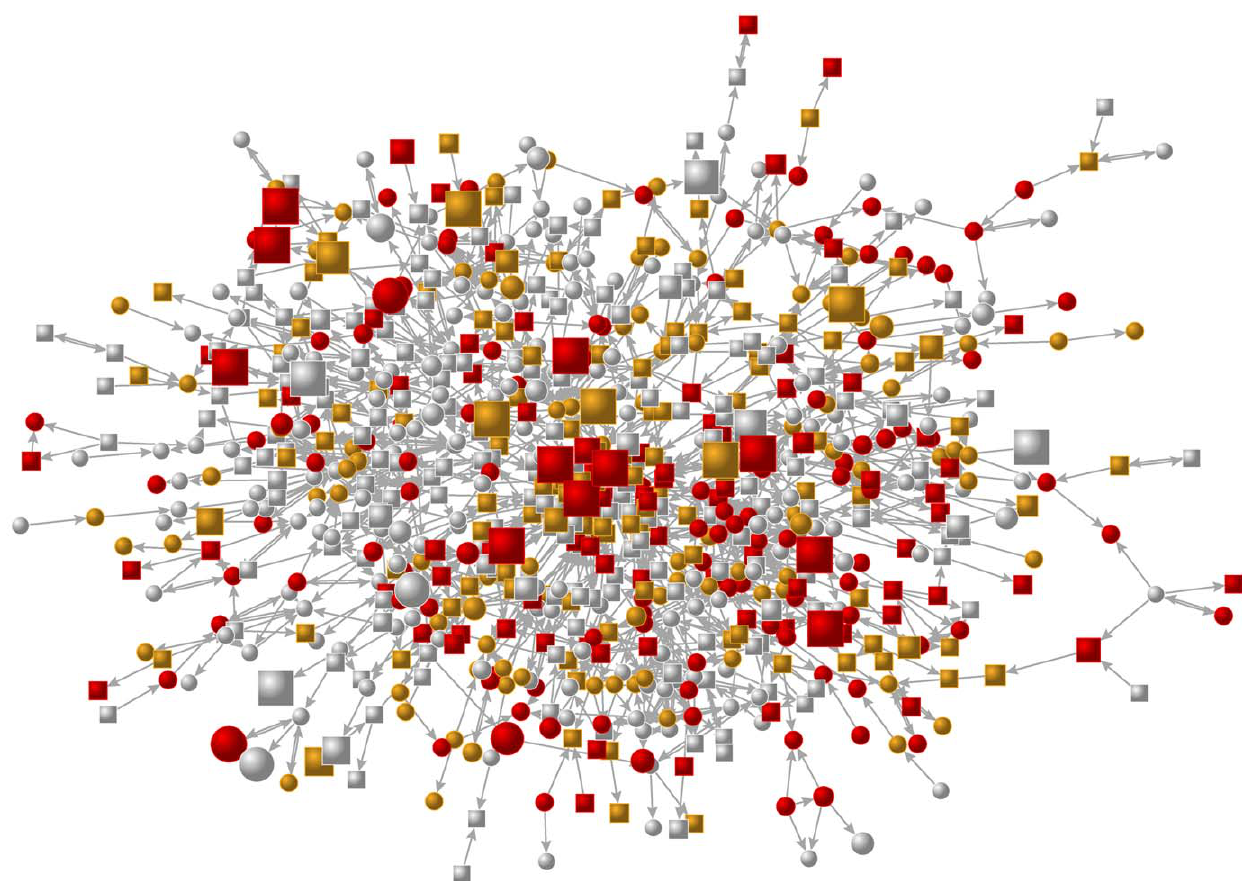
Figure 1. Network graph. Figure 1 is a network graph of the largest component of friends in Wave I of the Add Health study (year 1995), from a single school. Each node represents a subject (there are 800 shown) and its shape denotes gender (circles are female, squares are male). Lines between nodes indicate relationships (arrows point from the naming friend to the named friend). Node colour denotes nightly sleep duration (red for 6 hours or less, orange for 7 hours, white for 8 hours or more) and node size indicates frequency of marijuana use (the smallest nodes do not use marijuana, the largest report using at least daily). The network suggests clustering of both sleep and drug use behavior, and as we show in the statistical analysis, some of the overlap in clustering may result from a causal effect of sleep on drug use. Node placement is based on the Kamada- Kawai algorithm (see Text S1) [50].